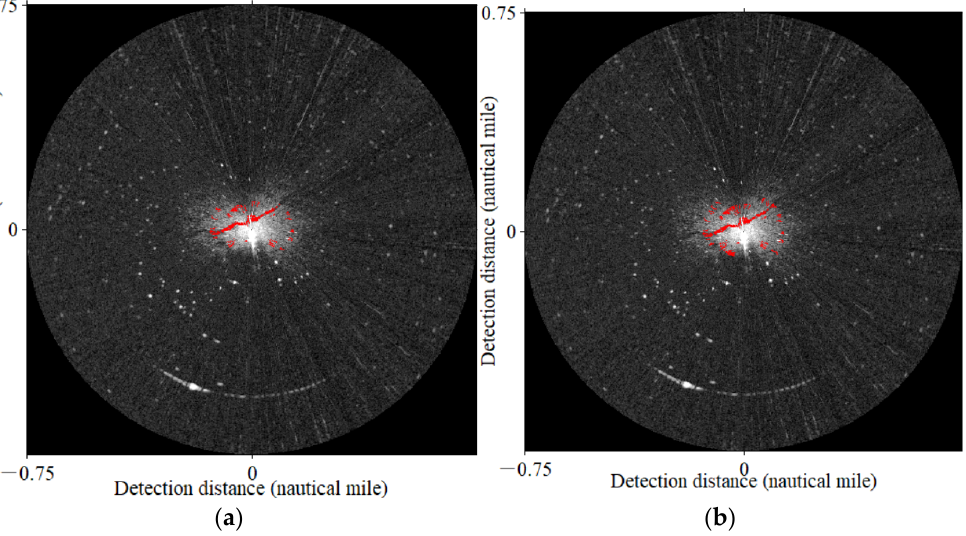
Figure 17. Results of Method 3. ( a ) The selected threshold in the gray distribution matrix was ‘145’; ( b ) The selected threshold in the gray distribution matrix was ‘100’. The segmentation results were marked in red.